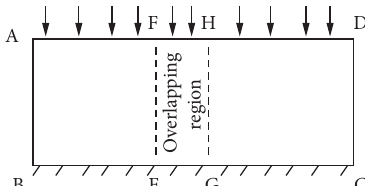
Figure 3: The diagram of overlapping domain decomposition for plane static problem. Define ABGH region: k u u � f u and u � g u (boundary GH). Define CDFE region: k v v � f v and v � g v (boundary EF).